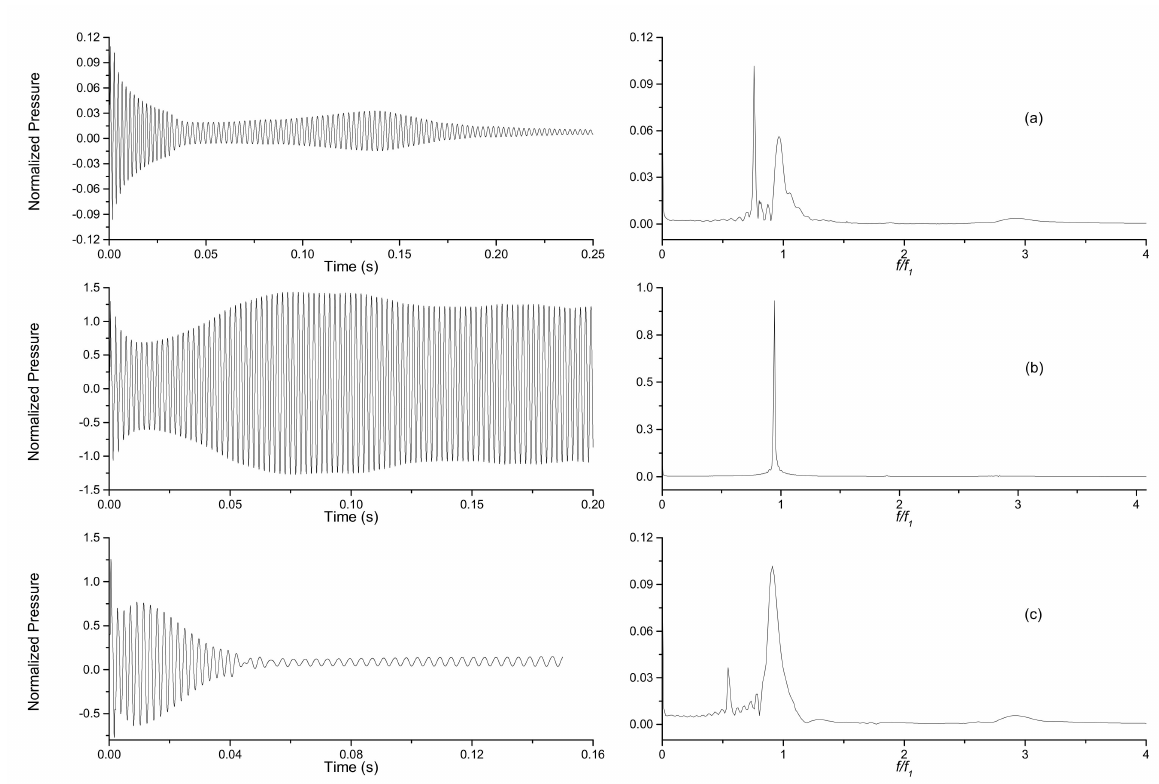
Figure 6. Time histories of static pressure at the monitoring point p 1 of circular pipe (case 1), St = 0.26 ( a ), St = 0.30 ( b ), St = 0.42 ( c